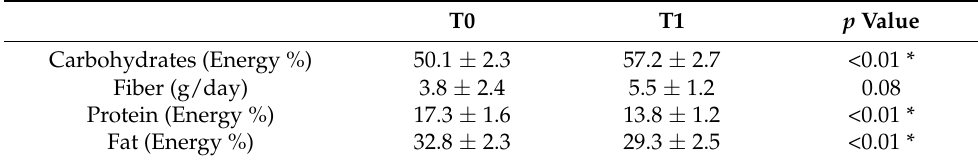
Table 3. Macronutrients intake of the study population at baseline and after six months.